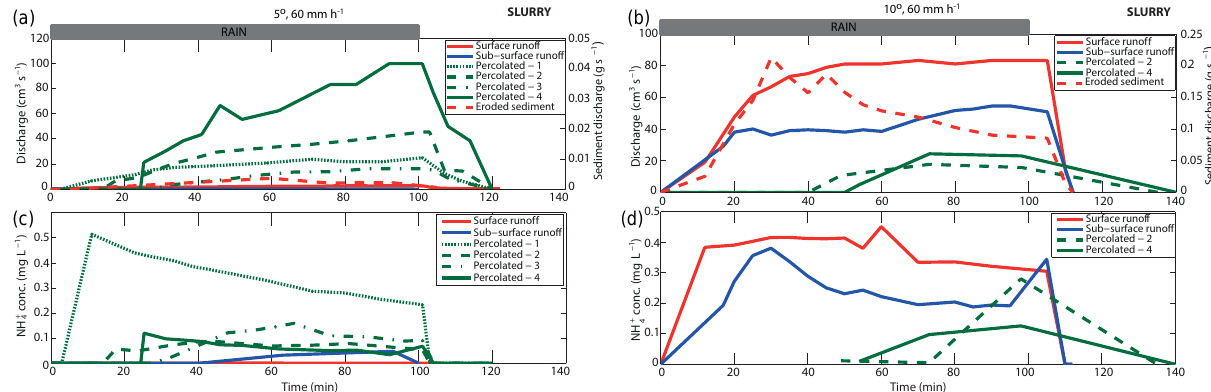
Figure 5. Plots showing water and sediment discharge (a, b) and NH + concentrations (c, d) from each monitored flow pathway for the 4 slurry-treated experiments at two slope angles (5 and 10 ◦ ) at 60mmh − 1 rainfall intensity. Where percolated 1–4 represent vertical transport from each of the pairs of tanks beneath the soil slope as marked in Fig. 1. Note: data which are absent reflect the lack of activation of a particular flow